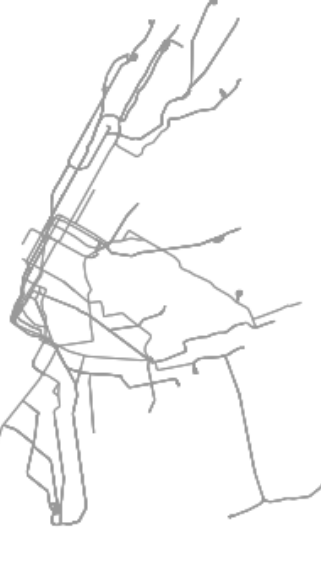
Figure 6: Output from codebox 18